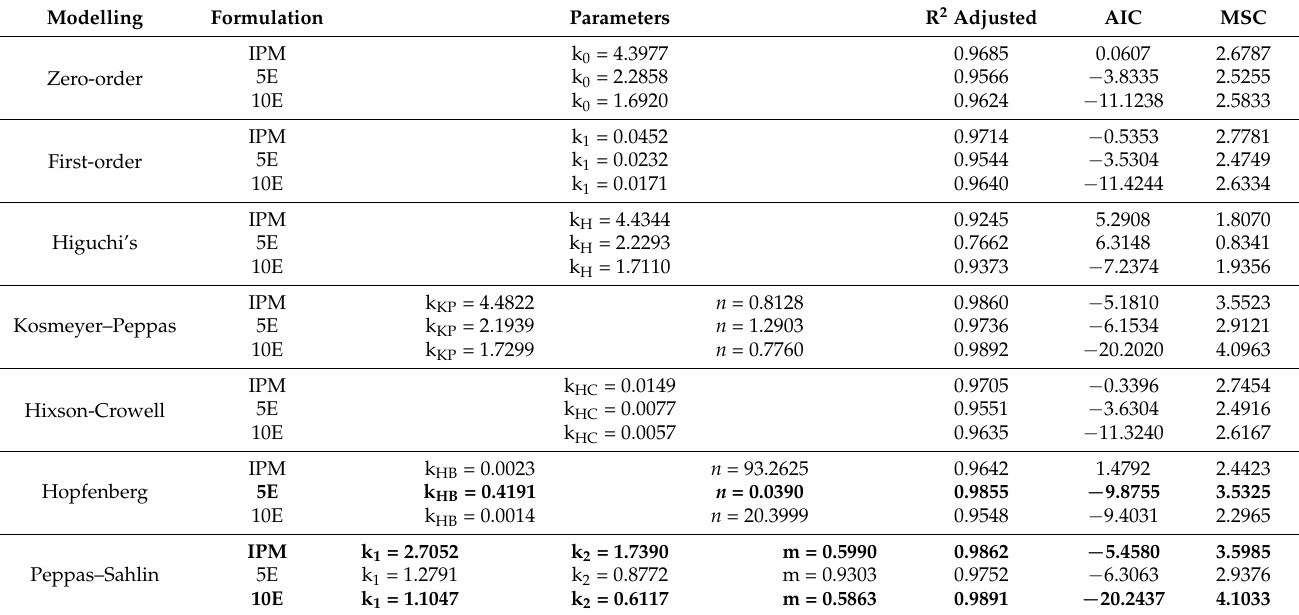
Figure 9. In vitro drug release of IBU-P407 effervescent matrix tablets in ( A ) pH 1.2 HCl buffer (0.1 N) and ( B ) pH-changed media. Table 3. Mathematical modelling of IBU release from effervescent matrix tablets in pH 1.2 HCl buffer (0.1